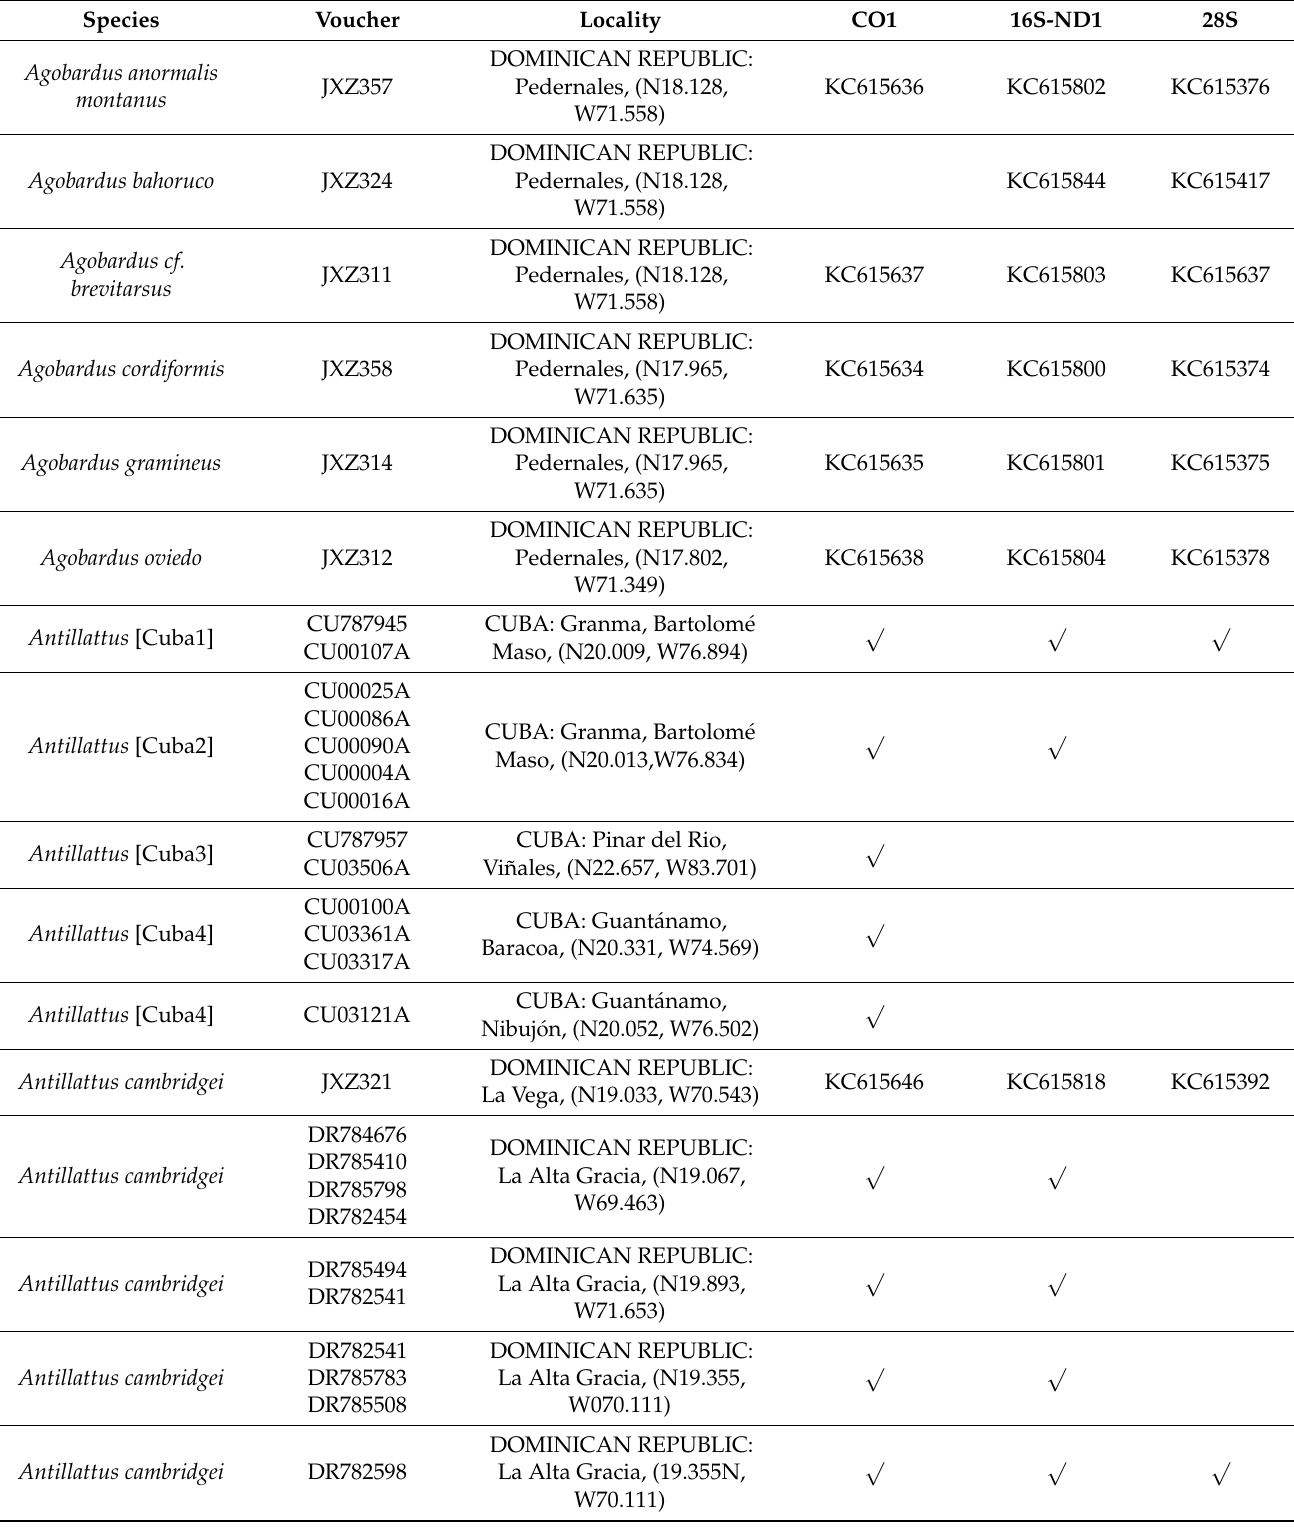
Table 1. Taxon sample with specific collection information and Genbank accession numbers of the previous published sequence. Checkmark (